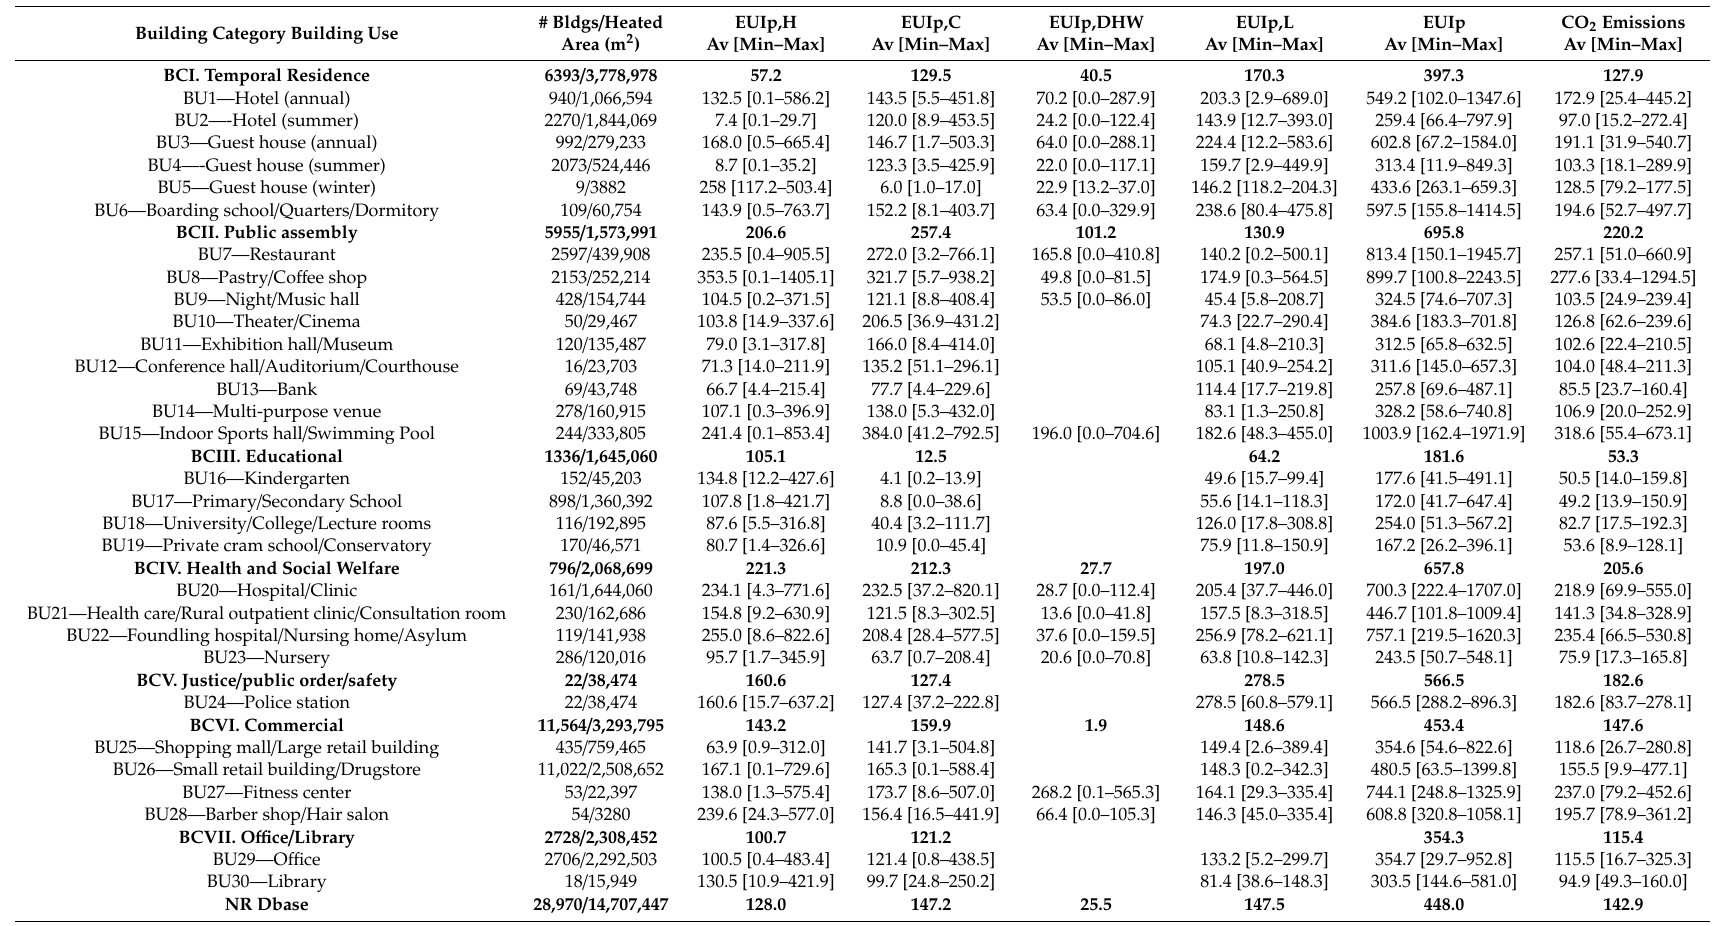
Table 1. Energy use (kWh / m 2 ) and CO 2 emission (kg / m 2 ) intensities for the di ff erent building categories and building uses in the NR